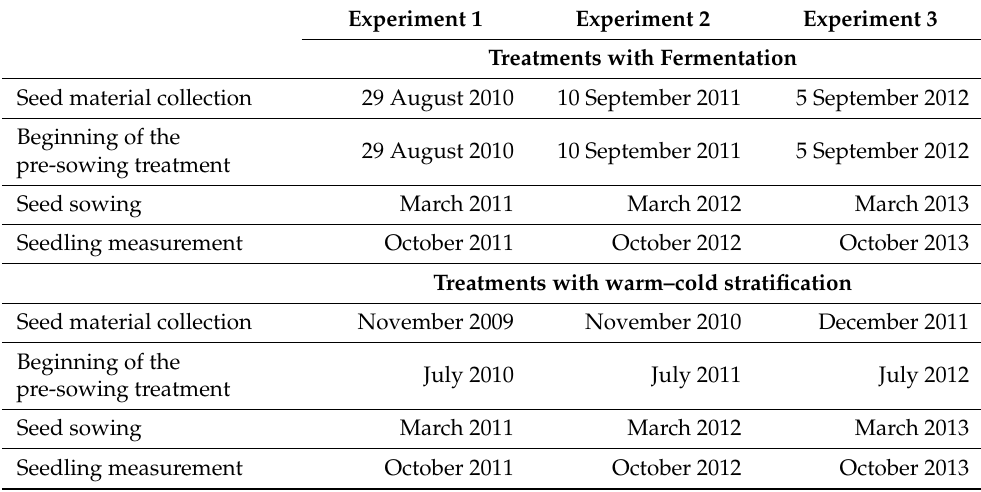
Figure 3. Seed material of small-leaved lime with the right maturity, suitable for fermentation. Table 4. A time overview of the main research field work in Experiment 1, 2 and 3.